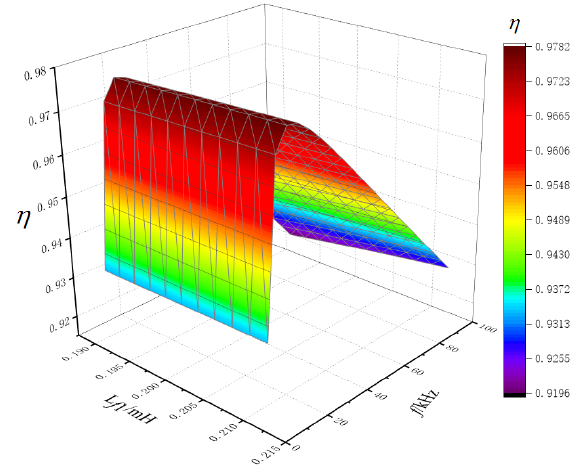
Figure 8. Efficiencies with the compensation inductance L f 1 and resonant frequency.